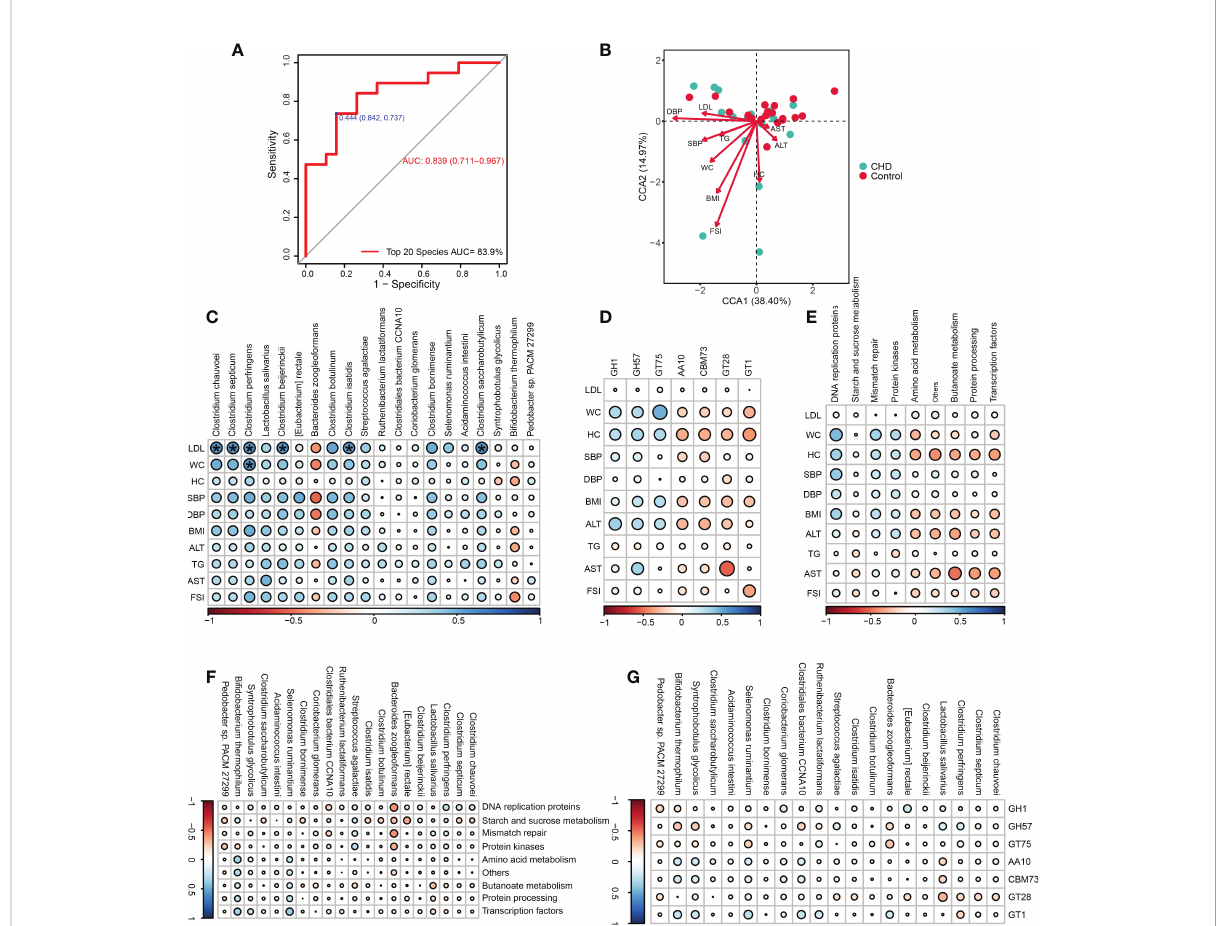
FIGURE 6 Microbial prediction value and clinical associations of key signatures. (A) The receiver operating characteristic (ROC) curve of the key signatures for CHD prediction. (B) Canonical correspondence analysis (CCA) between the bacterial community and altered physiological indicators. (C-E) Correlations among altered physiological parameters, key signatures, differential KOs and CAZymes. (F, G) Correlations among key signatures, differential KOs and CAZymes. * ‘ holm ’ adjust p-value < 0.05. WC, waist circumference; HC, hip circumference;BMI, body mass index; SBP, systolic blood pressure, DBP, diastolic blood pressure; LDL, low-density lipoprotein; FSI, fasting serum insulin; ALT, alanine aminotransferase; AST, aspartate aminotransferase; TG, triglyceride; AUC, the area under the ROC